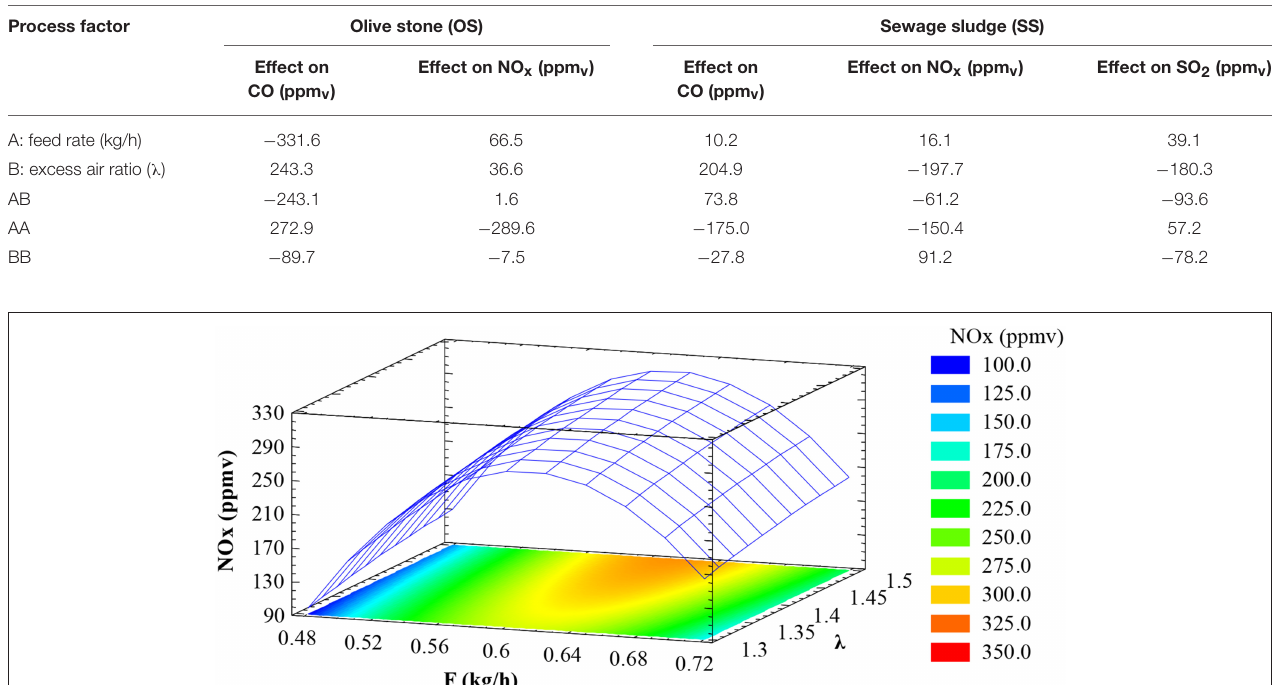
TABLE 4 | Main effects and interactions of feed rate (F) and excess air ( λ ) on the emissions (CO, NO x , and SO 2 ) for both fuels. Process factor